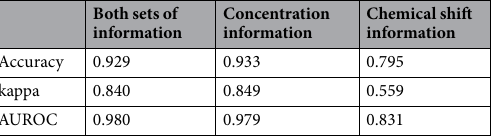
Table 1. Chemical shift information shows discriminative potential in the MTBLS1 dataset. However, it cannot enhance the excellent results given by concentration information during random forest classification.